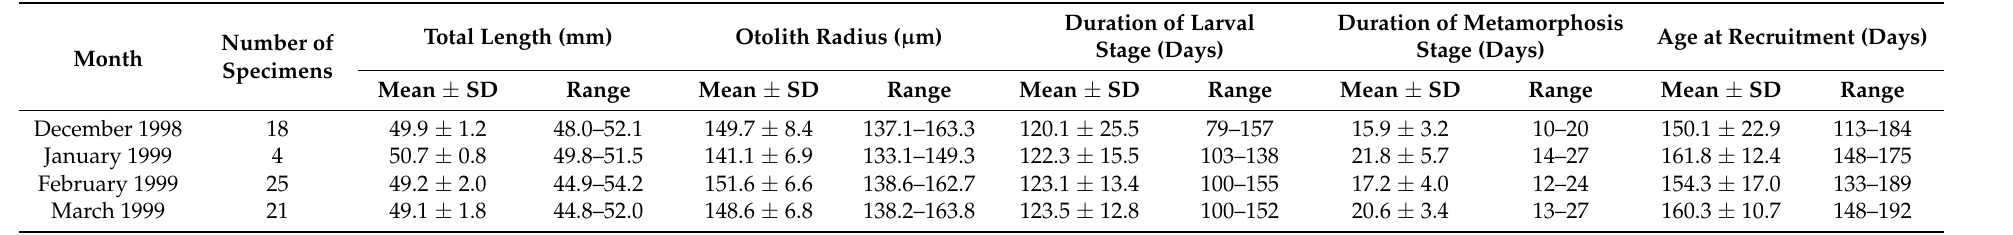
Table 1. Early life history characteristics of Anguilla marmorata recruited to southern Japan examined in this